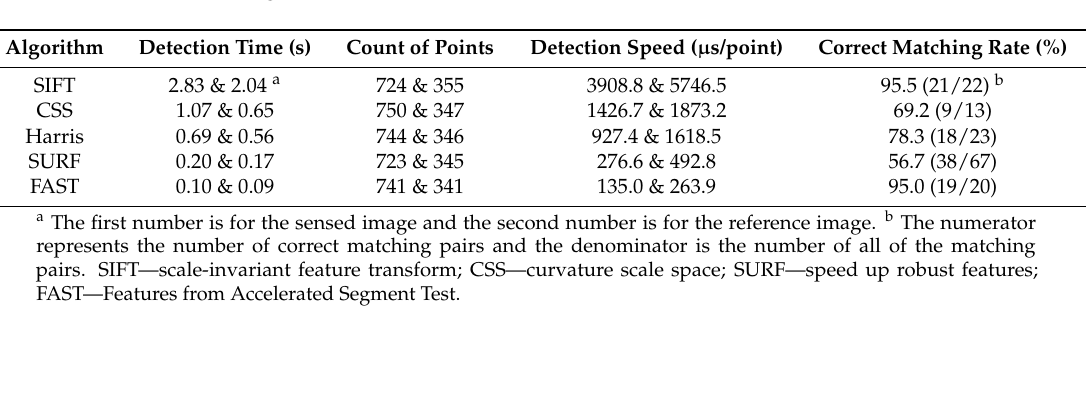
Table 1. Comparison of the detection speed and correct matching rate among five different detectors, based on the Local Image Set